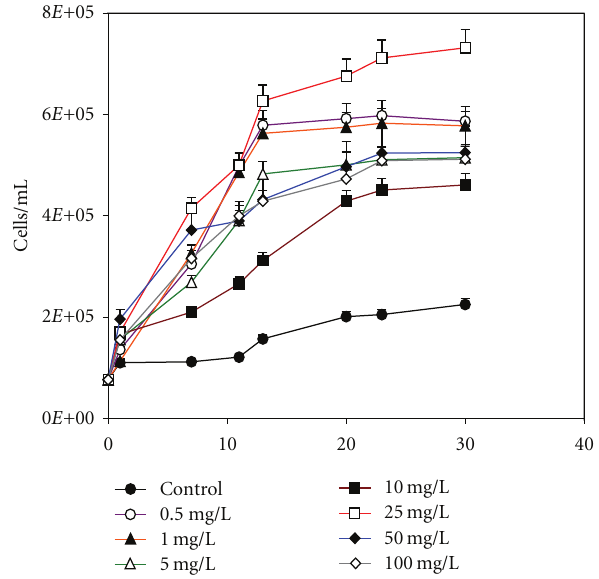
Figure 4: Scenedesmus sp. growth in the absence and presence of thorium up to 100.0